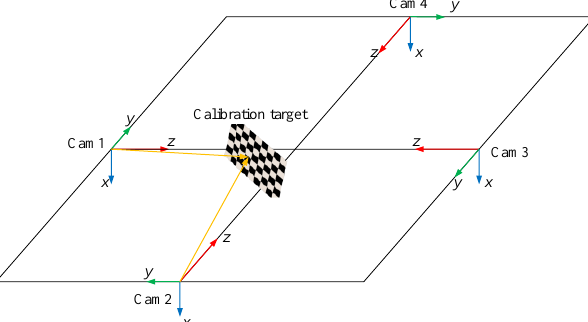
Figure 4. The extrinsic parameter calibration.